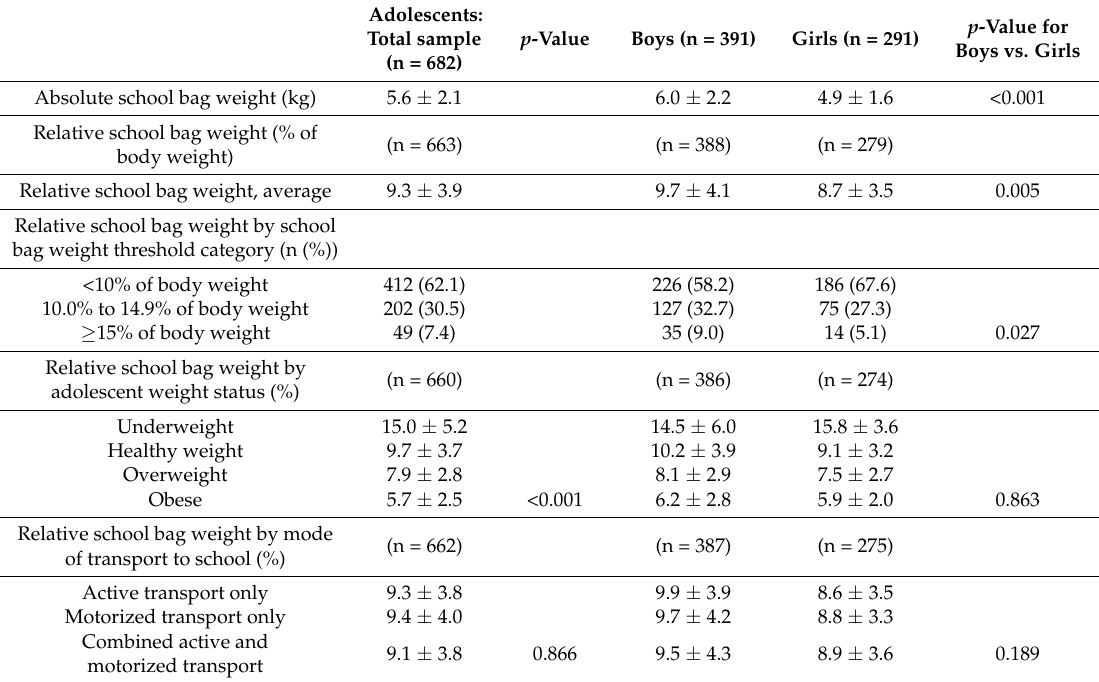
Table 2. Measured school bag